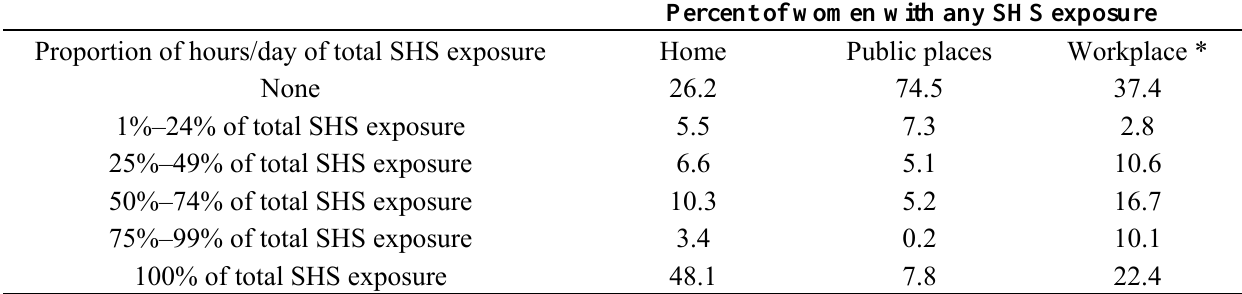
Table 6. SHS exposure sources relative to total SHS exposure among women with any exposure to SHS during third trimester of pregnancy (n = 1,002).